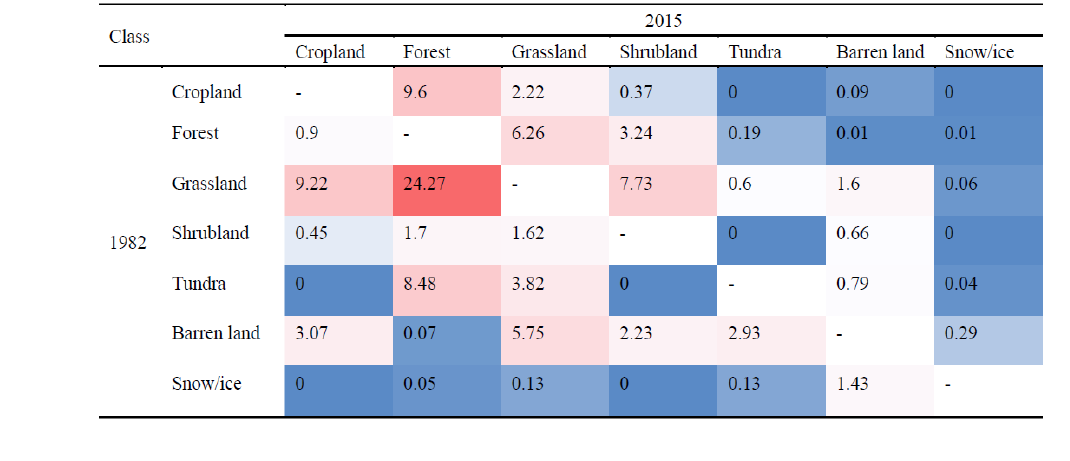
Table 13. Area ratio (%) of land cover conversions from 1982 to 2015, where the red color denotes a higher ratio and the blue color represents a lower ratio.